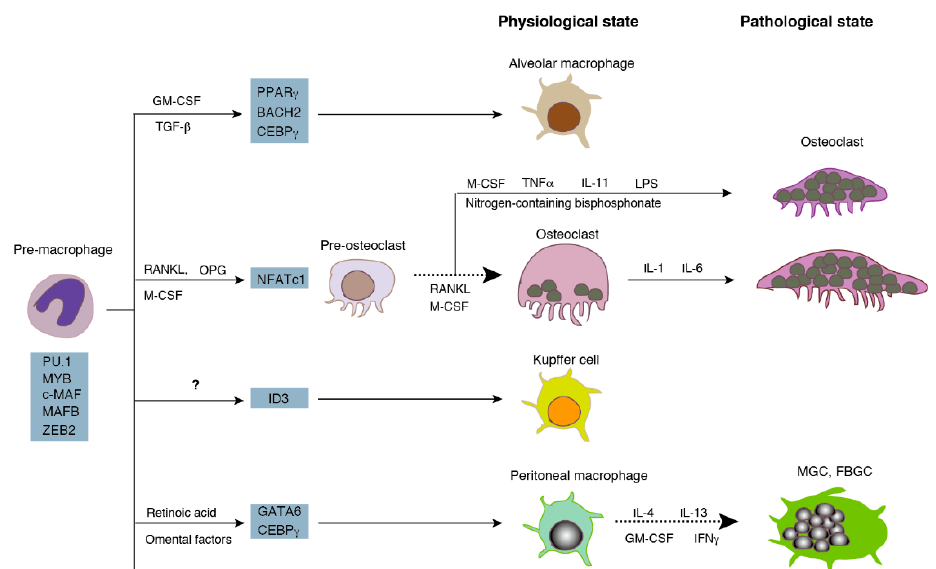
Figure 1. Di ff erentiation of osteoclasts and multinucleated macrophages. Macrophages and osteoclasts Figure 1. Differentiation of osteoclasts and multinucleated macrophages. Macrophages and are di ff erentiated from the same lineage. Osteoclasts are multinucleated cells at the physiological state. osteoclasts are differentiated from the same lineage. Osteoclasts are multinucleated cells at the Multinucleated giant macrophages are formed by infection, inflammation, and the foreign-body reaction. The broken arrows indicate the processes discussed in this review. Adopted and modified from